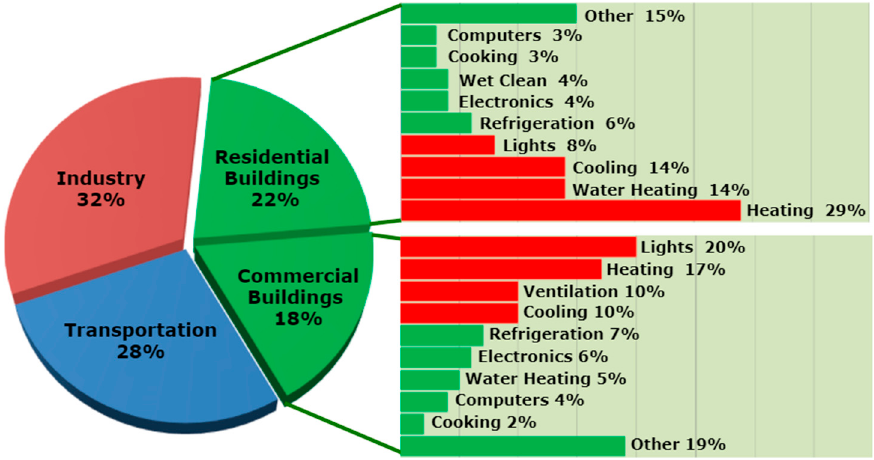
Figure 1. Energy consumption ratio of U.S.